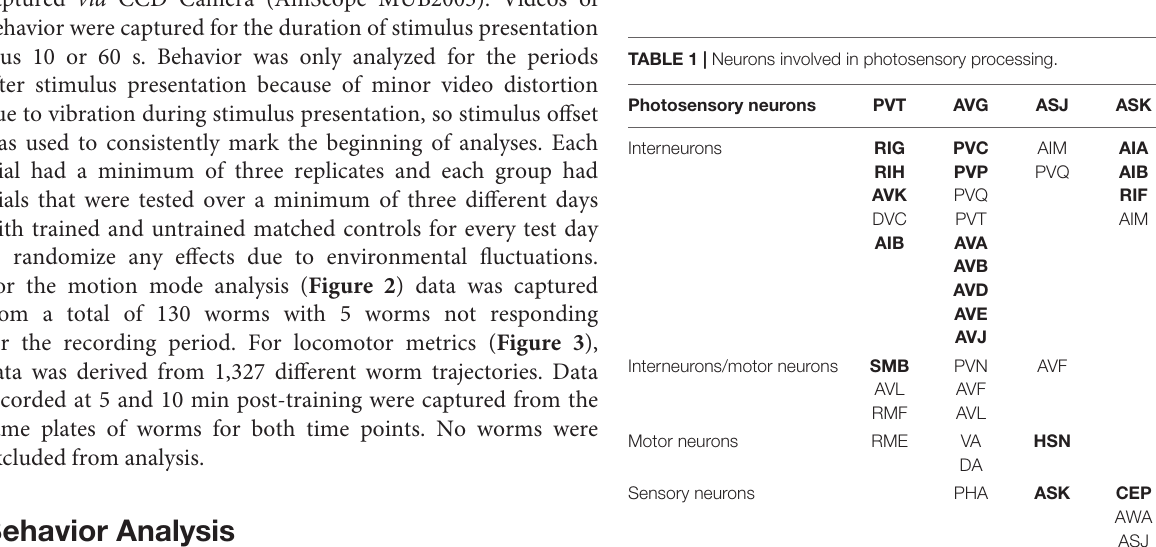
after the last pairing or following a comparable time period on the microscope for the Naïve group.